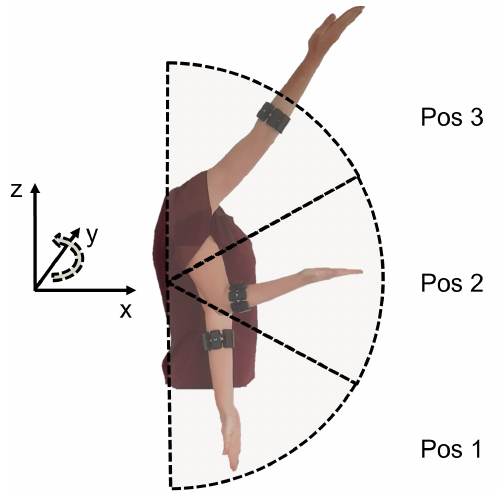
Figure 2. Pose estimation based on IMU data. Transformation of the IMU’s quaternions into a global reference system provides the rotation of the limb around a set Y axis. The Y rotation angle can be mapped to three predefined